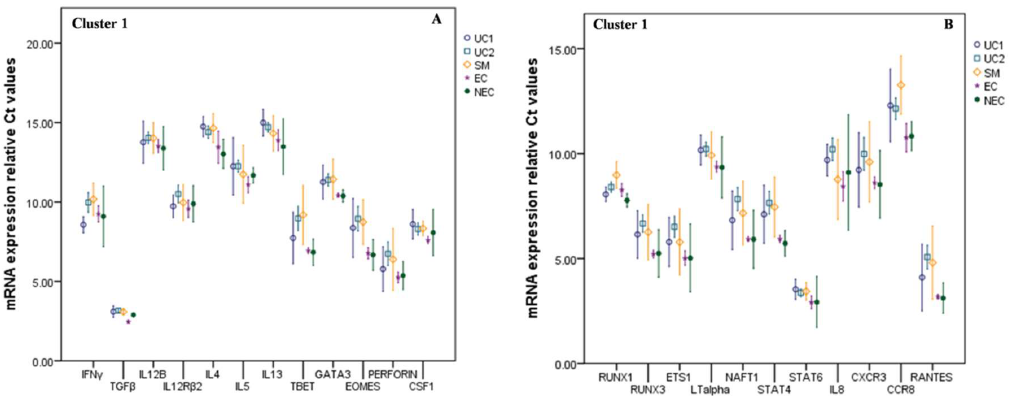
Figure 1. Relative mRNA expression profiling of cytokines and other regulatory factors showing di ff erential disease burden among malaria subgroups are presented as Ct values. Expressions